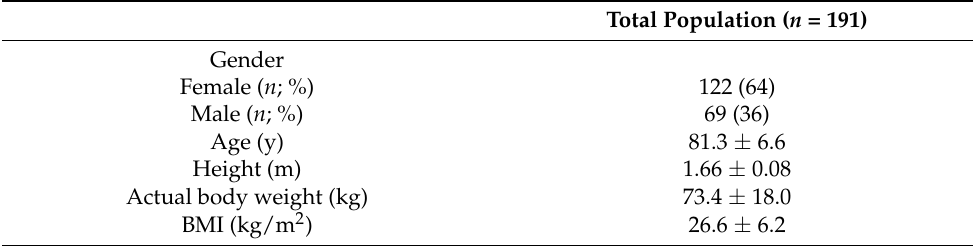
Table 1. Characteristics of the study